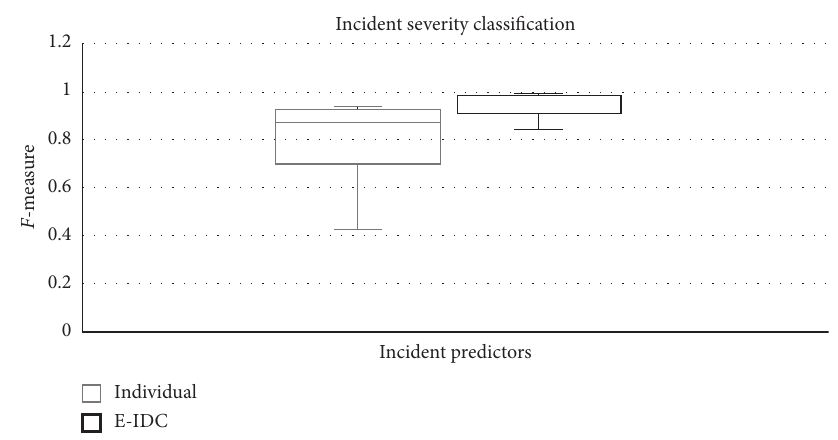
Figure 7: Boxplot of incident severity classification.